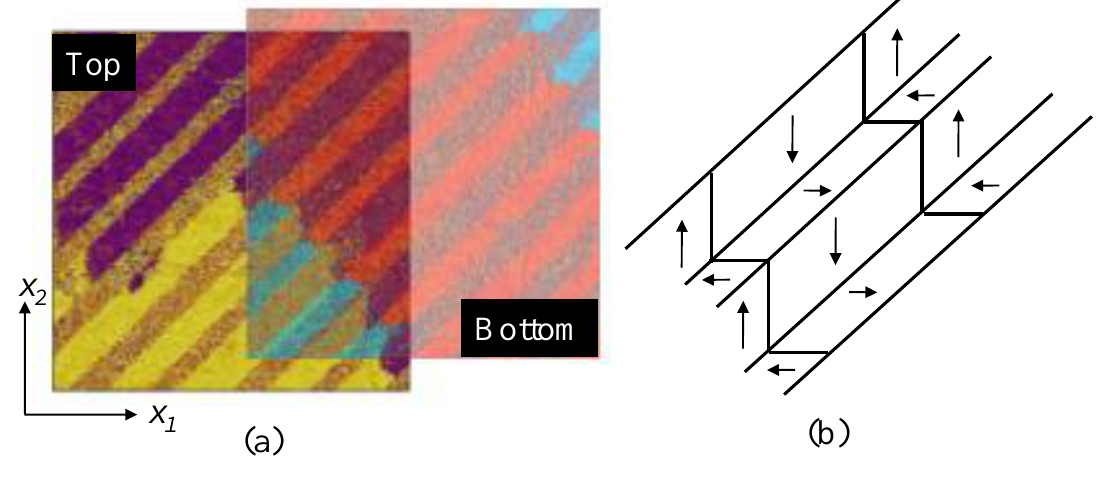
Figure 13. (a) Lateral piezoresponse force microscopy on a barium titanate single crystal showing herringbone structure (two 40µm regions ), schematically represented in (b)